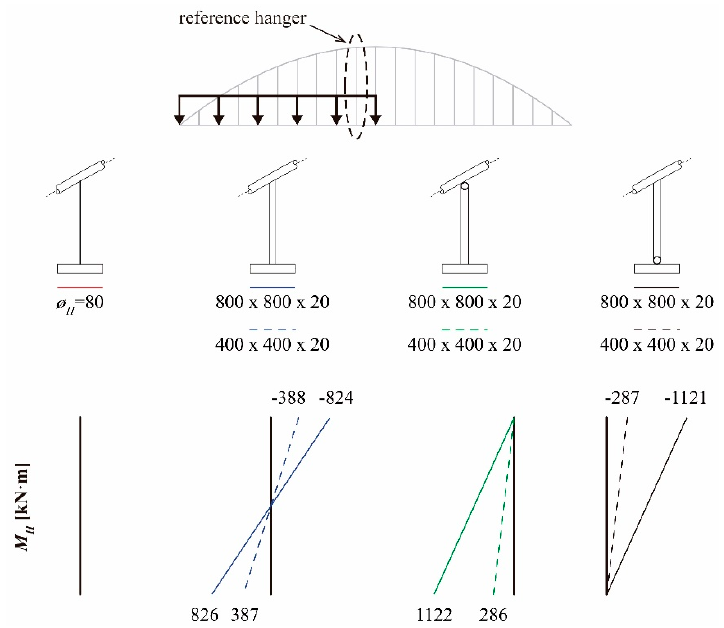
Figure 12. Pinned and stiff hangers comparison: bending moment distribution at a hanger.